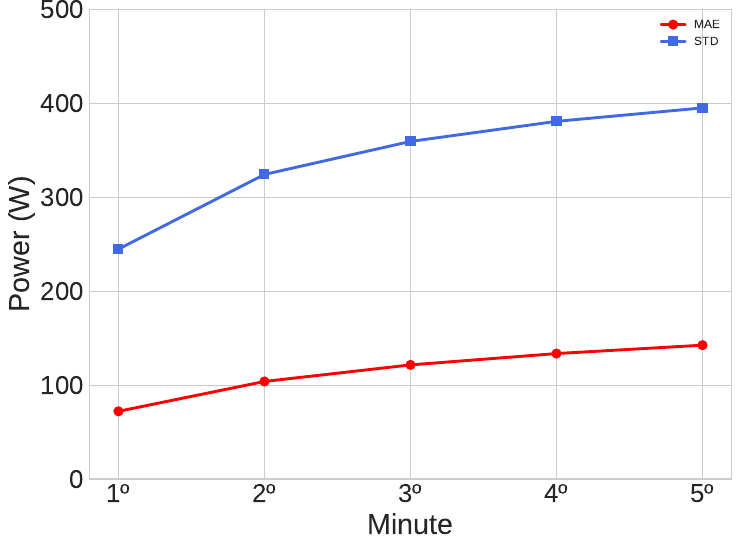
Figure 7. Mean Absolute Error (MAE) and Standard Deviation (STD) in the test phase of the optimized MLP model as a function of the minute prediction